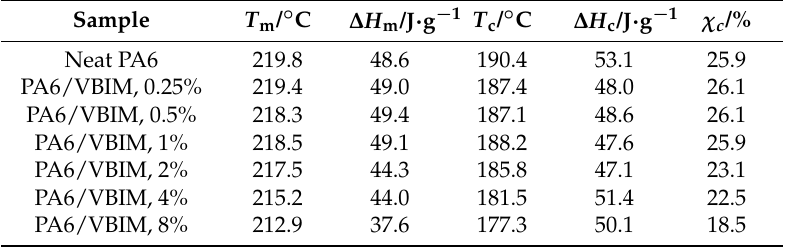
Table 1. The detailed thermal properties of PA6 and the PA6 blends with different VBIM contents based on DSC curves.